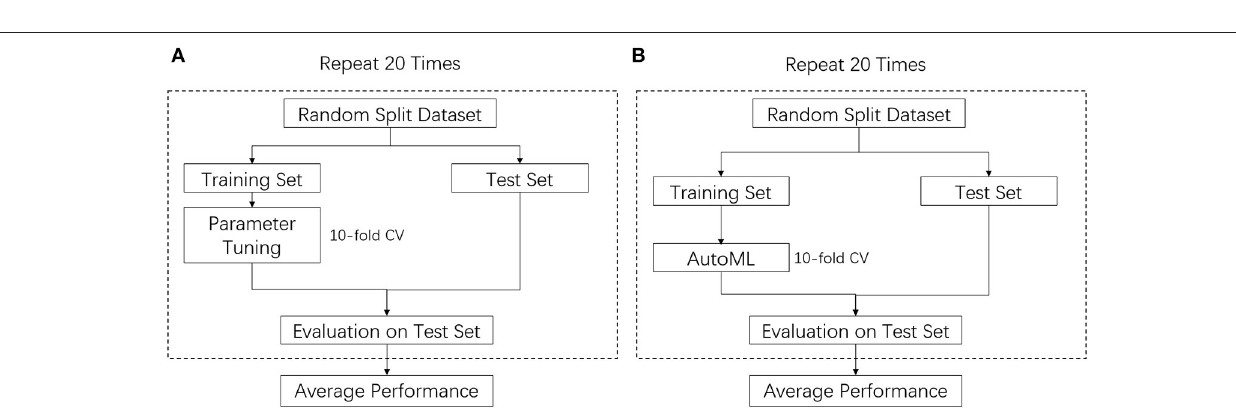
FIGURE 2 | Training and evaluation procedures for manual ML (A) and AutoML (B)